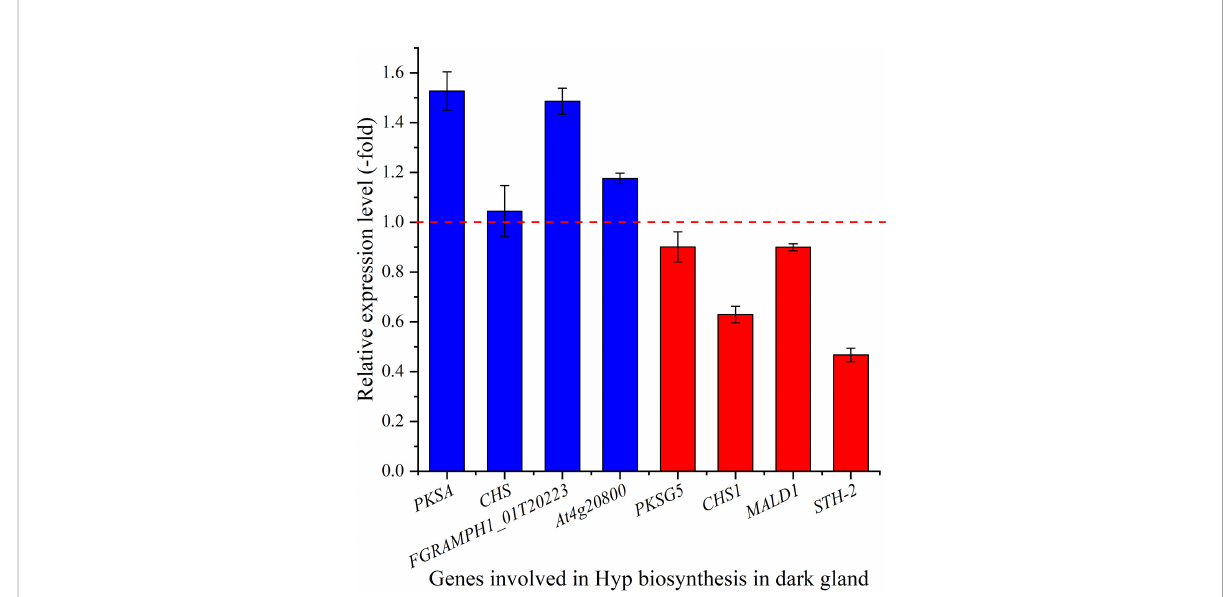
FIGURE 8 The expression level of genes involved in Hyp biosynthesis in dark gland for seedlings grown at 15 versus 22°C, as determined by qRT-PCR (n=3). Column highlighted in blue represents gene up-regulation and red represents gene down-regulation. The red dotted line in the image differentiates up-regulation (>1) and down-regulation (<1) at 15°C compared with 22°C (Control),